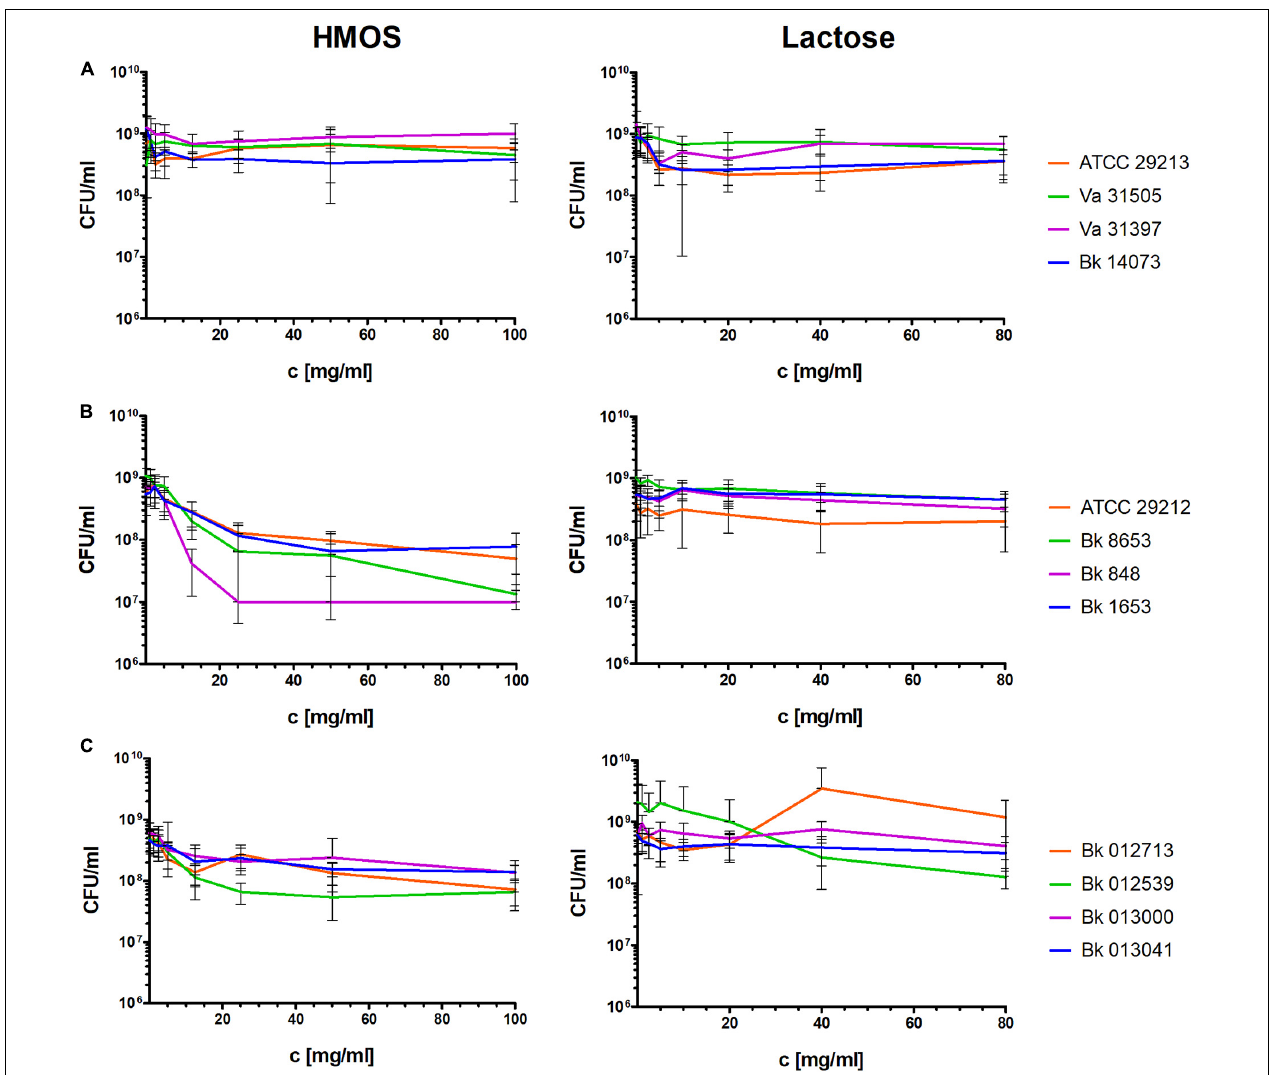
FIGURE 2 | Effects of total HMOs and lactose on laboratory and clinical strains of different Gram-positive species after 24 h of growing under planktonic conditions (assuming that lactose makes up 80% of the HMOs). (A) S. aureus , (B) E. faecalis , (C) E.